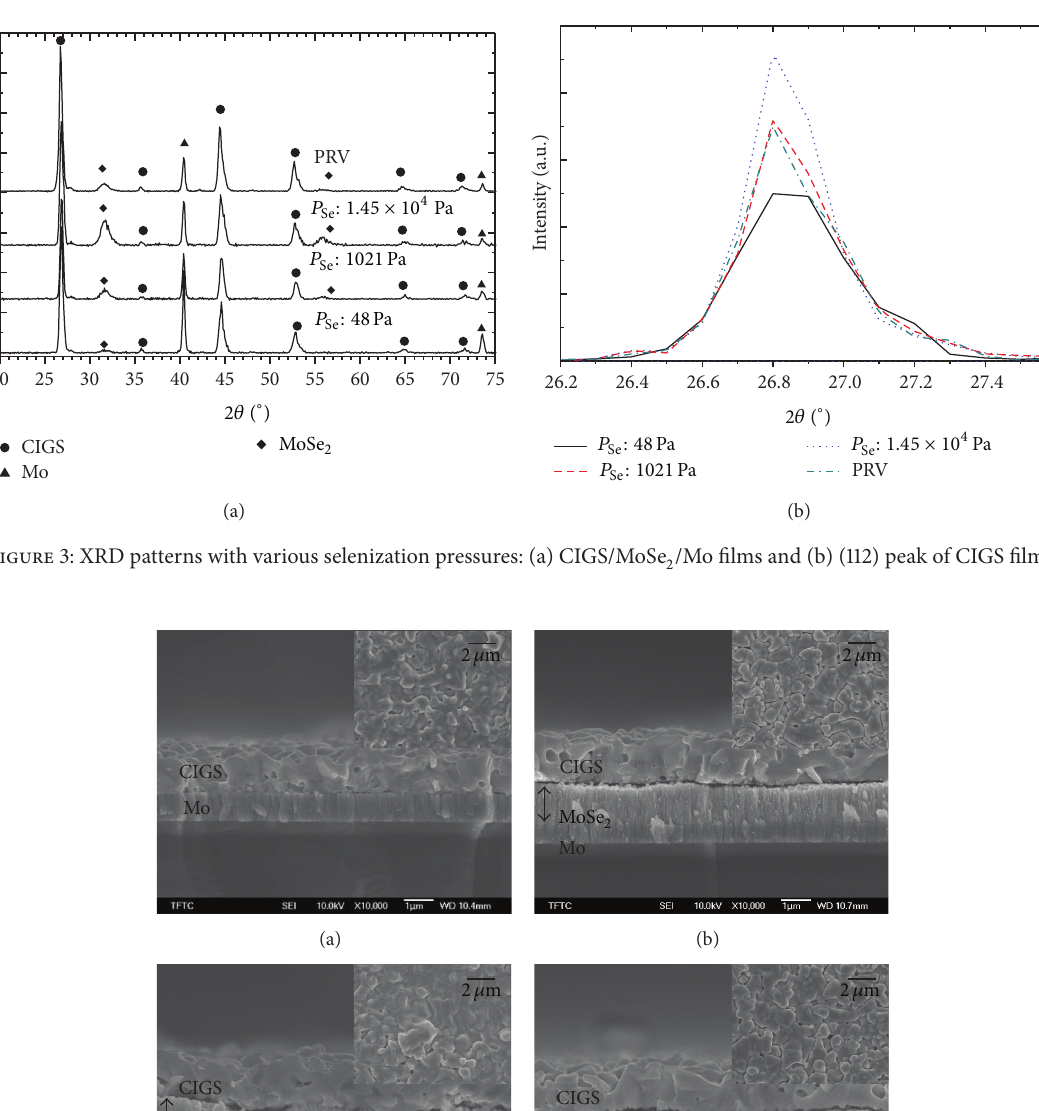
pressures. The CIGS films were about 1.5 𝜇 m thick.